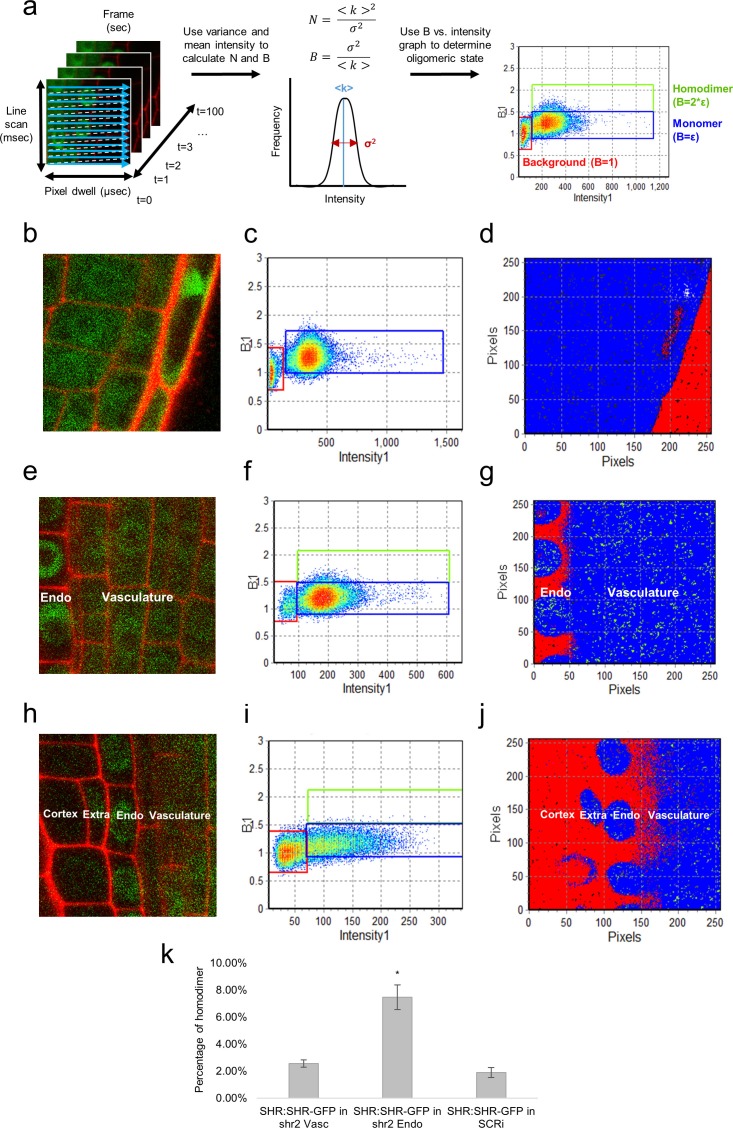
N&B analysis of the SHR oligomeric state.(a) Schematic of image acquisition and N&B analysis. (Left) Image acquisition for N&B is the same as for RICS analysis. (Middle) The mean and variance of intensity used to calculate the brightness and number of particles. (Right) The background brightness (red) set to 1 by adjusting the S-factor (Table 2). The monomer (blue) positioned at the predetermined brightness of monomeric GFP (Table 2). Homodimer (green) particles shown to be twice as bright as the monomer. (b, c, d) 35S:GFP used to determine the molecular brightness of monomeric GFP (b, e, h) Region of interest selected for N&B analysis of 35S:GFP, SHR:SHR-GFP in shr2, and SHR:SHR-GFP in SCRi. Cell walls are marked with PI. Note that the extra layer in (h) is a result of the SCRi background. (c, f, i) Brightness vs intensity for 35S:GFP, SHR:SHR-GFP in shr2, and SHR:SHR-GFP in SCRi. The red, blue, green boxes indicate the autofluorescence (B = 1), monomer (B = ε = 0.28 ± 0.01) and homodimer (B = 2*ε), respectively. (d, g, j) Color-coding of the brightness for 35S:GFP, SHR:SHR-GFP in shr2, and SHR:SHR-GFP in SCRi. Red, blue, and green represent background (autofluorescence), monomer, and homodimer, respectively. (k) Bar graph showing average percent of SHR homodimer for SHR:SHR-GFP in vascular cells (n = 40), SHR:SHR-GFP in endodermal cells (n = 19), and SHR:SHR-GFP in SCRi (n = 14). Error bars are s.e.m. Star denotes sample that is significantly different from the other two (Wilcoxon with Steel-Dwass, p<0.05). Source data is provided in Figure 3—source data 1–3.DOI:
http://dx.doi.org/10.7554/eLife.14770.01410.7554/eLife.14770.015Figure 3—source data 1.Oligomeric state of SHR:SHR--GFP in shr2 line obtained using N&B with the Zeiss 780 and Zeiss 710 instruments.DOI:
http://dx.doi.org/10.7554/eLife.14770.01510.7554/eLife.14770.016Figure 3—source data 2.Oligomeric state of SHR:SHR--GFP in SCRi line obtained using N&B with the Zeiss 780 instrument.DOI:
http://dx.doi.org/10.7554/eLife.14770.01610.7554/eLife.14770.017Figure 3—source data 3.Statistical analysis of the oligomeric state of SHR collected using N&B.